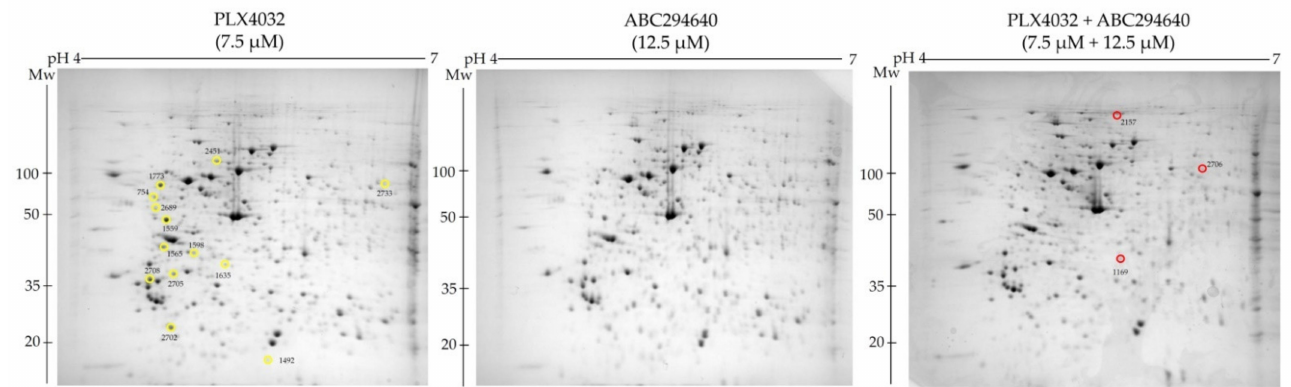
Figure 6. Representative 2-DE gel images of total cell lysates obtained in the pH range 4–7 (7cm IPG strips) from RKOr cells treated with either individual drugs or their combination. Experiments were performed in four biological replicates for each treatment condition. Yellow circles denote protein spots that were significantly decreased in combined treatment relative to each single-drug treatment, while red circles indicate significantly upregulated protein spots. Table 3. Down- and up-regulated proteins with statistical significance ( p ≤ 0.055) in vemurafenib-resistant RKO colon cancer cells cultured in the presence of combined treatment with vemurafenib and ABC294640 in comparison with single- drug treatments with either vemurafenib or ABC294640. Protein identification was carried out by MALDI-TOF/TOF mass